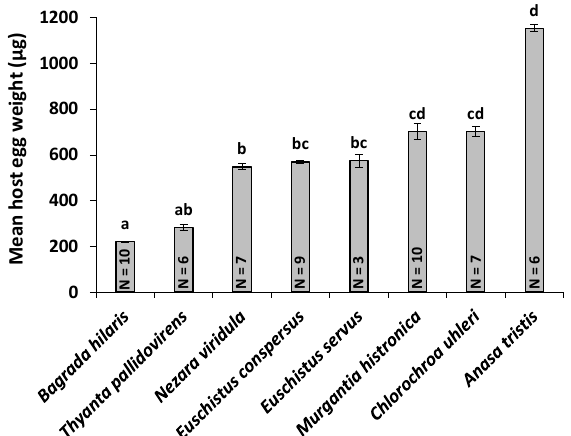
Figure 2. Comparison of mean ( ± SE) egg weight among different hosts. N is the number of replicates. Significant differences are represented by different letters (Dunn’s Kruskal–Wallis multiple comparison, p < 0.05).